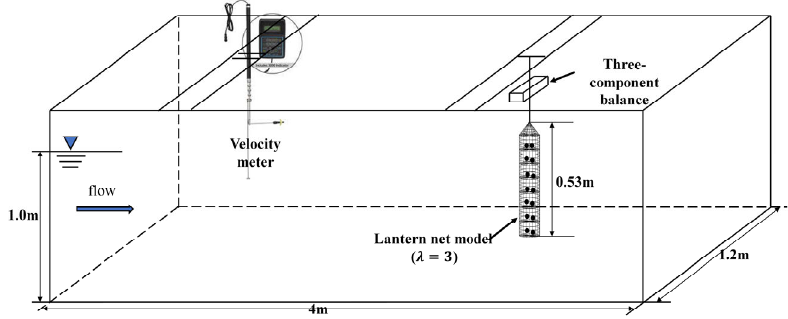
Figure 2. Hydrodynamic experiment setup of the lantern net model in the flume tank.